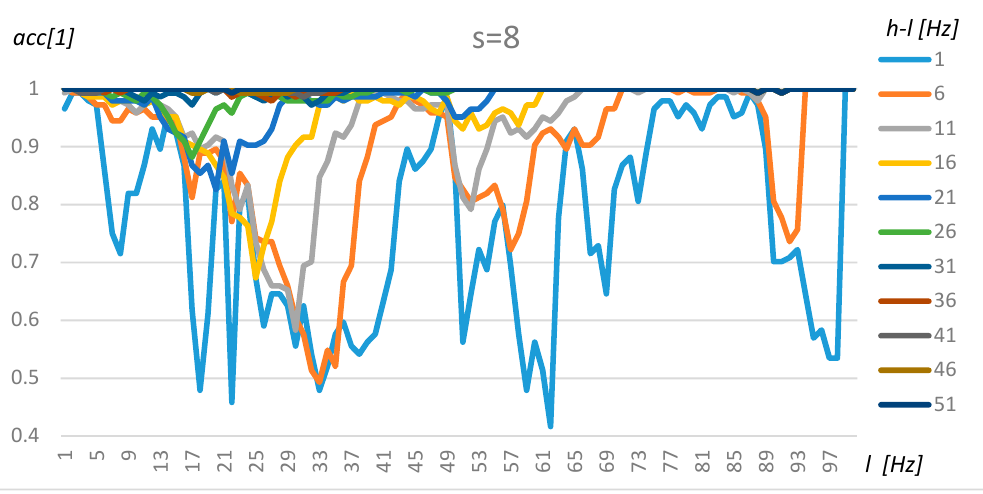
Figure 9. The accuracy value for Transformer 1, s = 8, and various l and h parameters.